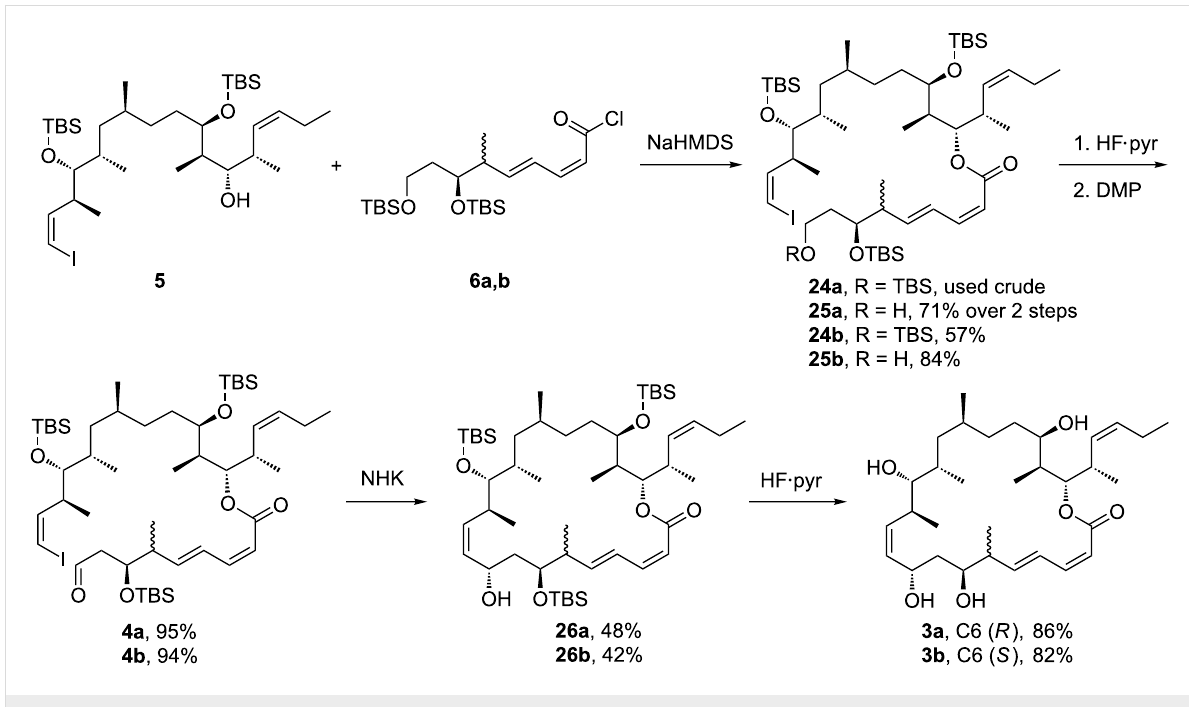
Scheme 5: Coupling with the bottom fragment and end game.